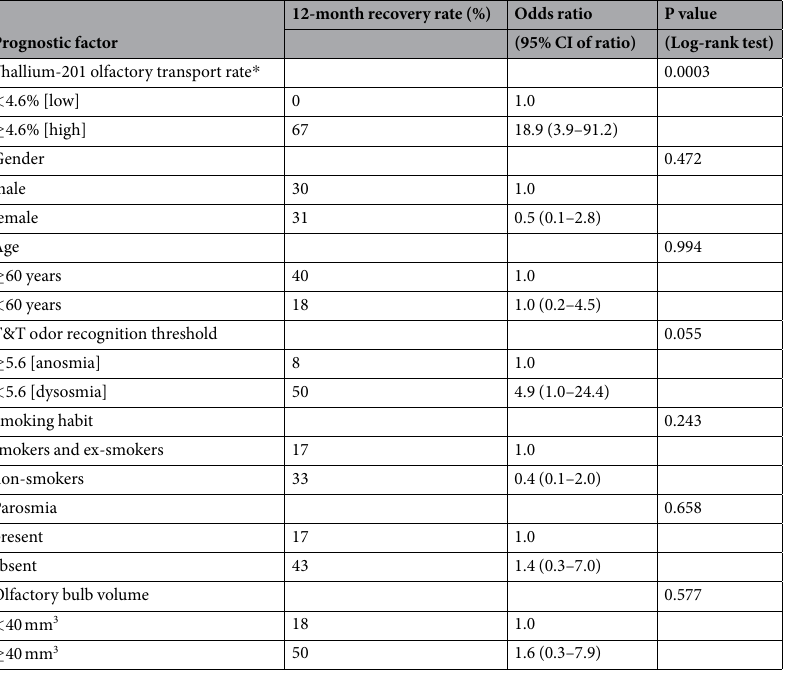
Table 1. Relationship between various factors and time to recovery. * Data dichotomized at the optimal cutoff value; the improvement in the T&T odor recognition threshold was judged according to the criteria of the Japanese Rhinologic Society [12] (cure, T&T odor recognition threshold ≤ 2.0; remission, decrease in the T&T odor recognition threshold ≥ 1.0; progress, increase in the T&T odor recognition threshold of ≥ 1.0; stable, all other cases). Cure or remission was defined as